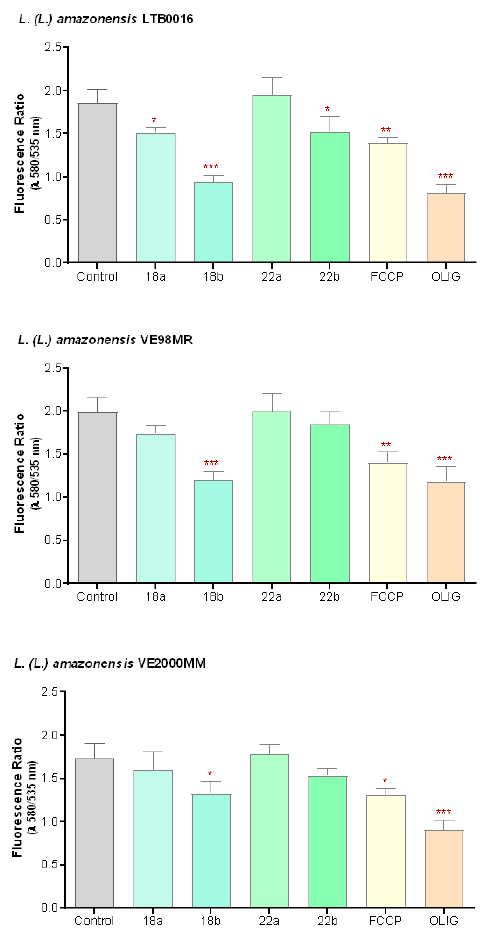
Figure 2. Effect of betulin derivatives on mitochondrial membrane potential ( ∆Ψ m) in L. (L.) amazo- nensis reference strain LTB0016 and isolates VE98MR and VE2000MM promastigotes isolated from patients, at two increasing concentrations (a and b): 18 (1 and 2 µ M), 22 (2 and 4 µ M), incubated for 48 h. Each bar represents the average ( n = 3 independent experiments in duplicate) with its respective standard error (SEM). * p < 0.05; ** p < 0.005; *** p < 0.0005 with respect to the control without treat- ment. Control: untreated control; FCCP: carbonyl cyanide 4-(trifluoromethoxy) phenylhydrazone, 1 µ M; OLIG: oligomycin, 20 µ